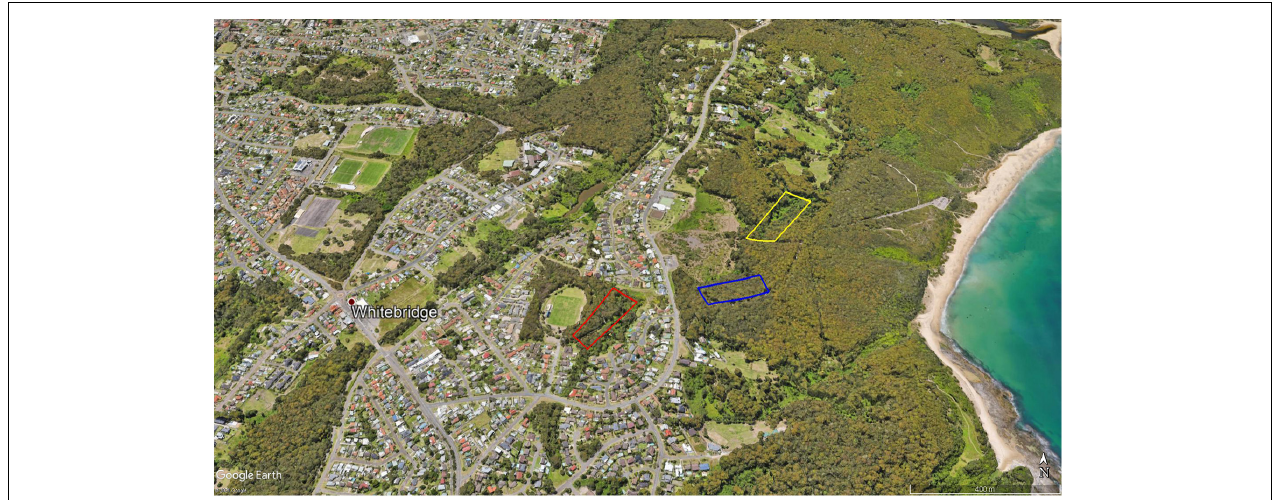
FIGURE 1 | Map depicting the broad area of each study site, within the suburb of Whitebridge, New South Wales, Australia. The “close environment,” an urban green space, is depicted in red. The “mid environment,” a state-owned heavily vegetated patch of land on the edge of a conservation area, is depicted in blue. The “far environment,” a remnant rainforest in a conservation area, is depicted in yellow. Glenrock State Conservation Area is the large forested area between the beach and the main road. Map sourced from Google